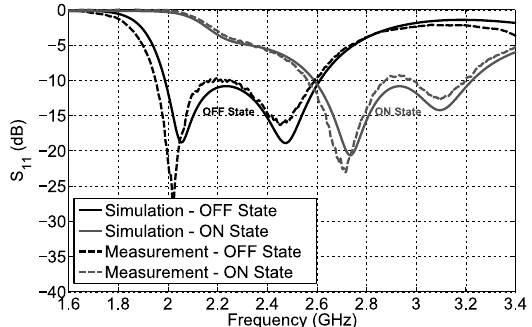
FIGURE 20. Simulated and measured impedance matching performance for the final optimized frequency reconfigurable E-shaped patch antenna including the bias lines. Adapted from [26].